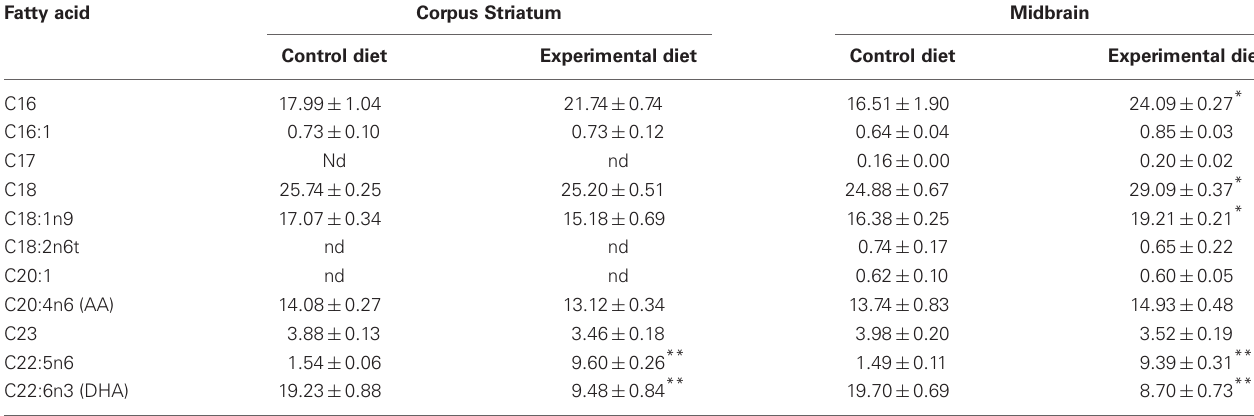
Table 5 | Fatty acid composition (% of total) in Corpus Striatum and Midbrain membrane phospholipids of F2 generation groups raised on Control or Experimental